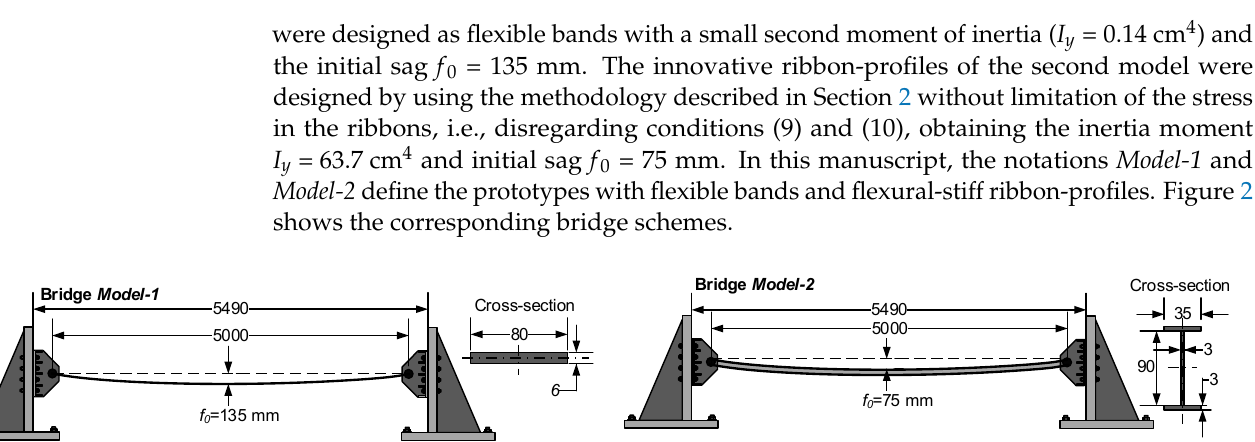
Figure 2. Geometry characteristics of the prototypes with different flexural stiffness of stress-ribbons: ( a ) the bridge with flexible bands; ( b ) the bridge with flexural-stiff ribbon-profiles.